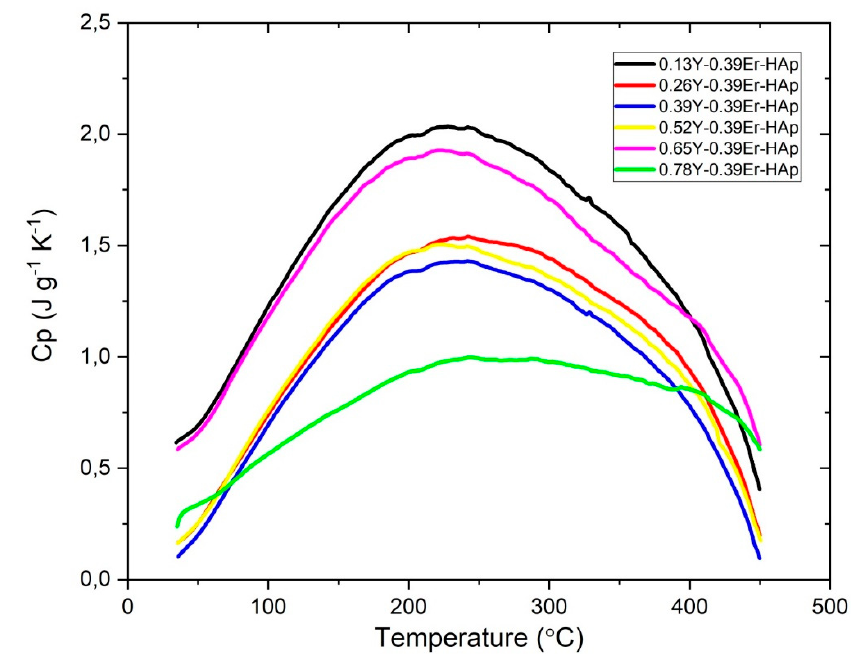
Figure 8. Heat capacity as a function of temperature plot for each sample.